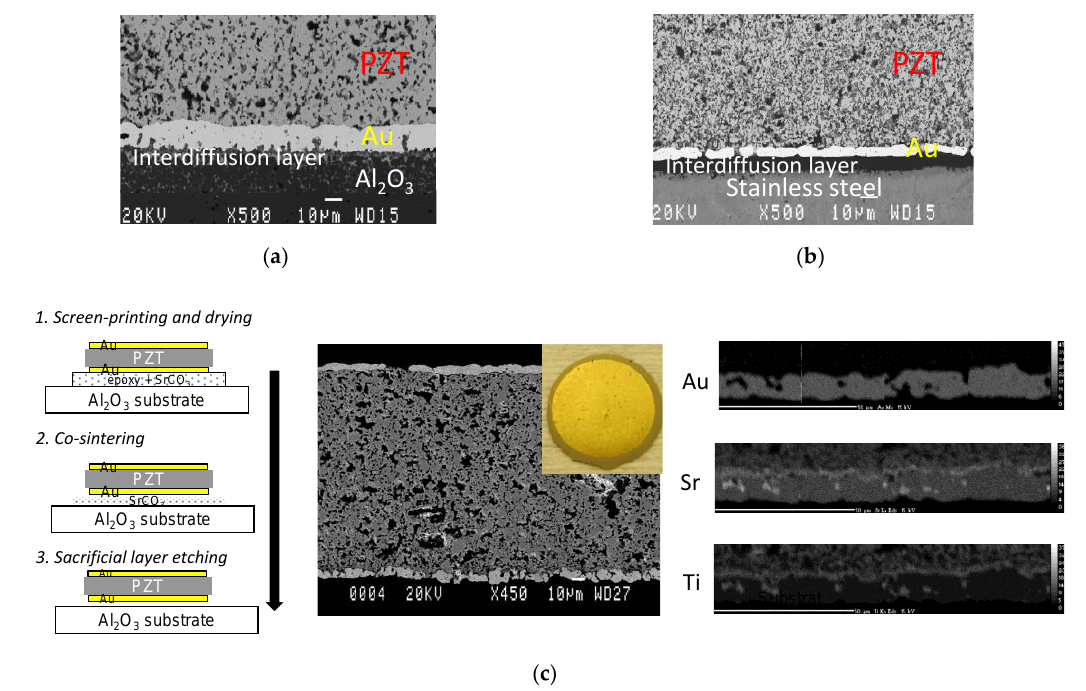
Figure 5. Comparison of SEM microstructures of PZT + LBCu screen-printed layers sintered on different supports (alumina substrate, stainless steel substrate, or epoxy + SrCO 3 ). ( a ) Au/PZT/Au on alumina substrate. ( b ) Au/PZT/Au on stainless steel substrate (SS301). ( c ) Totally released Au/PZT/Au disks after deposition on epoxy + SrCO 3 sacrificial layer and acidic dissolution in phosphoric acid. (left) Fabrication steps; (middle) SEM of a microsection; (right) Castaing micropobe analysis at the PZT / bottom electrode interface adapted with permission from [30] copyright 2014